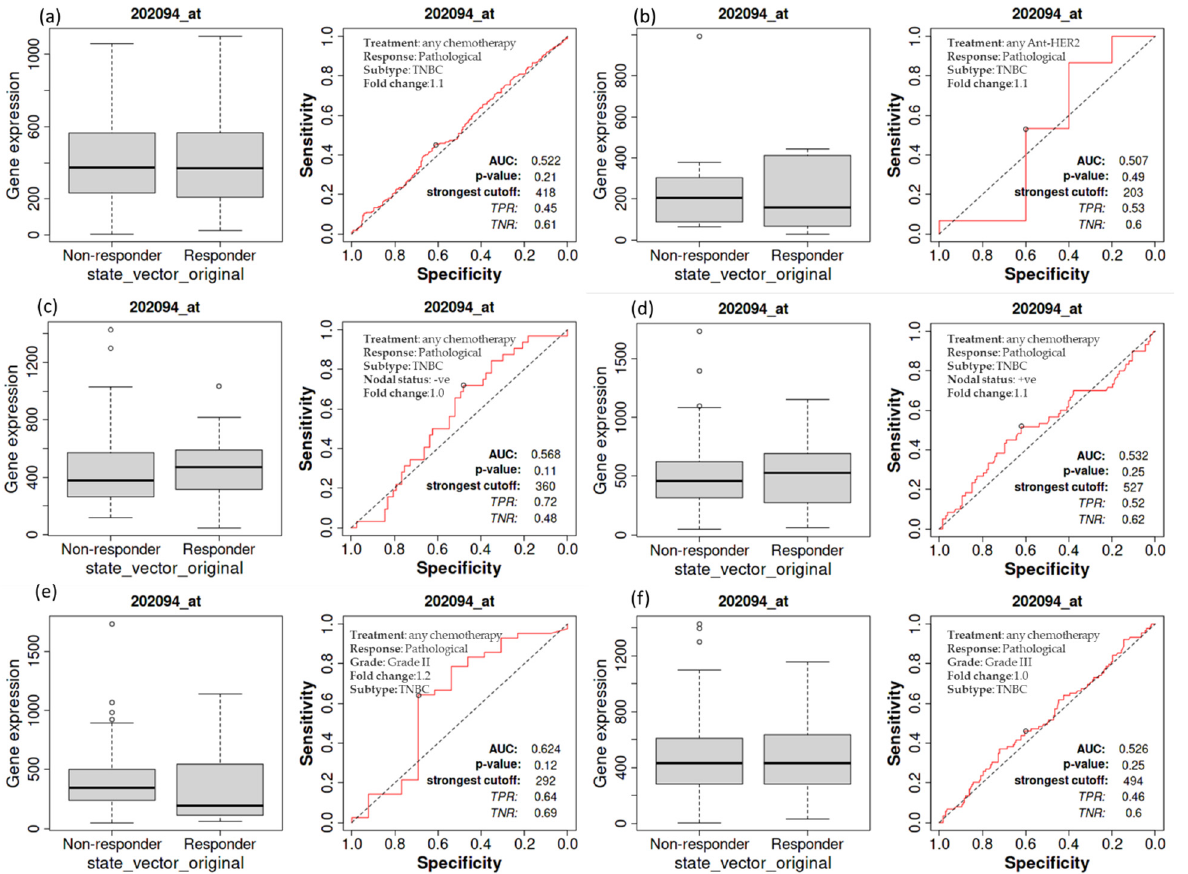
Figure 5. The relationship between BIRC5 expression and complete pathological response in TNBC patients. TNBC patients receiving any chemotherapy ( a ) and anti_HER2 therapy ( b ) have no signif- icant difference from those patients not receiving any type of treatment. TNBC patients with nodal status negative ( c ) and positive ( d ), as well as with grade II ( e ) and III ( f ), treated with any type of chemotherapy.